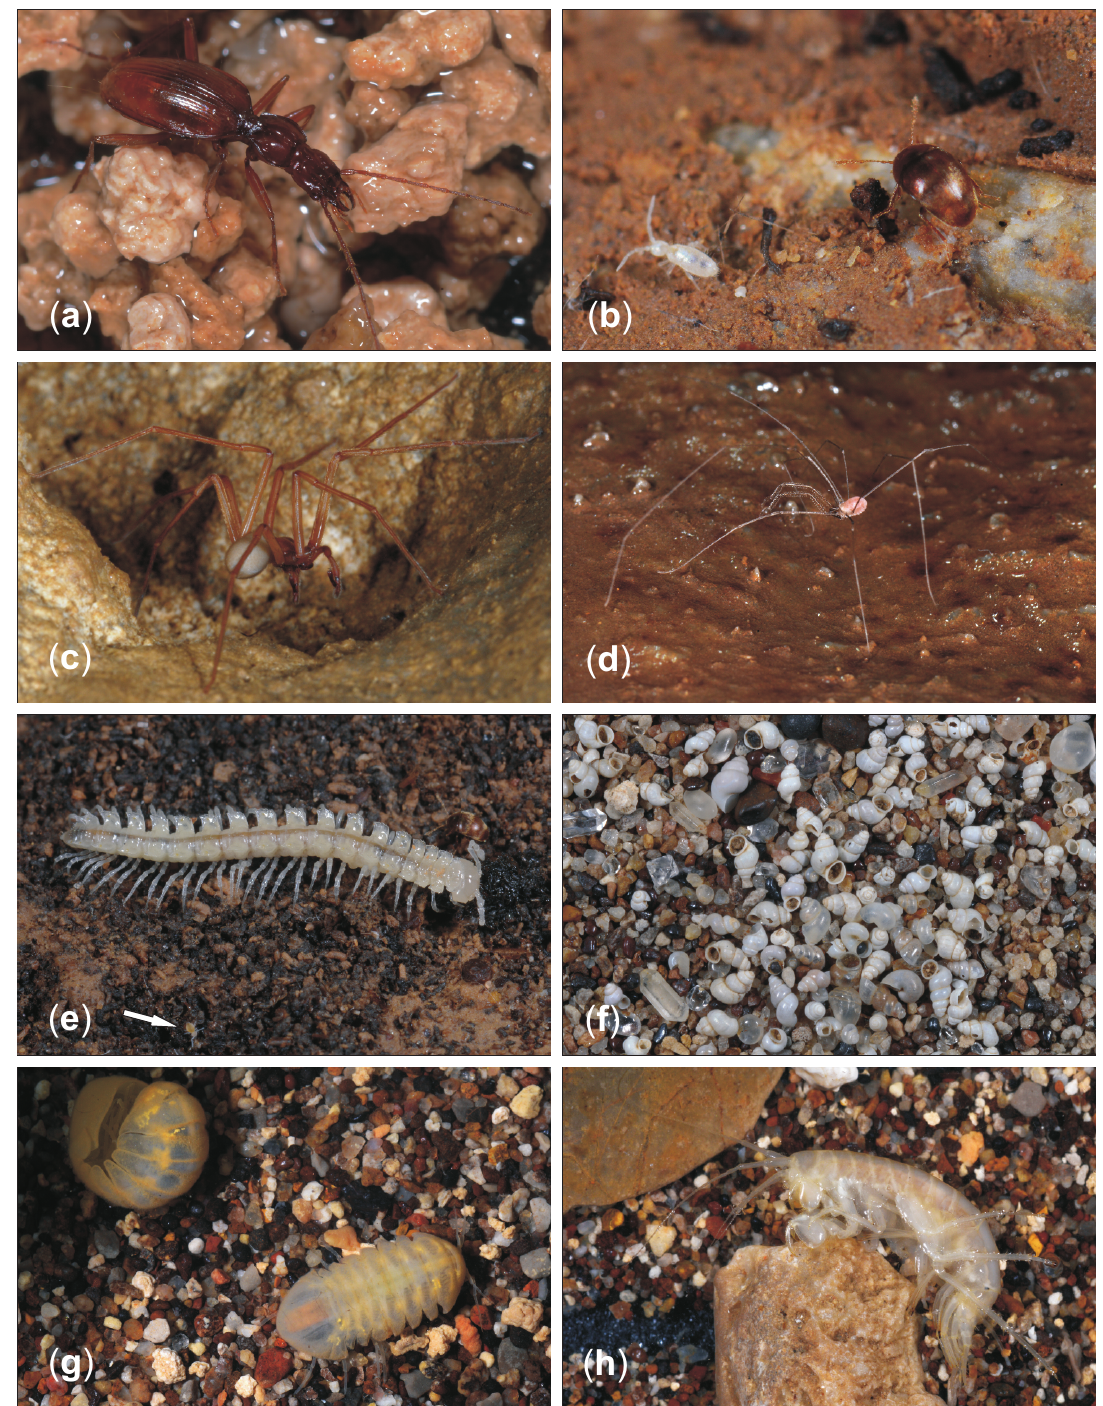
Figure 3. Troglobiotic and stygobiotic fauna from Križna jama: ( a ) Ground beetle ( Typhlotrechus bilimekii frigens ). ( b ) Lep- todirine beetle ( Bathyscimorphus (Drovenikia) trifurcatus ), on the right and Collembolan ( Troglopedetes pallidus) , on the left. ( c ) Cave spider ( Parastalita stygia ). ( d ) Cave Harvestman ( Hadzinia ferrani ). ( e ) Cave Millipede ( Brachydesmus inferus concavus ) and Collembolan ( Pygmarrhopalites sp.), indicated with white arrow. ( f ) Various species of aquatic snails from family Hydrobiidae and quartz crystals. ( g ) Sphaeromatid isopod ( Monolistra racovitzai ). ( h ) Cave amphipod ( Niphargus orcinus